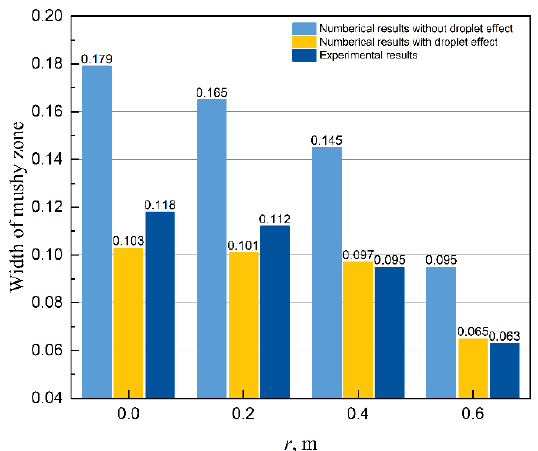
Figure 22. Comparison of the width of mushy zone between the experimental value and the numerical